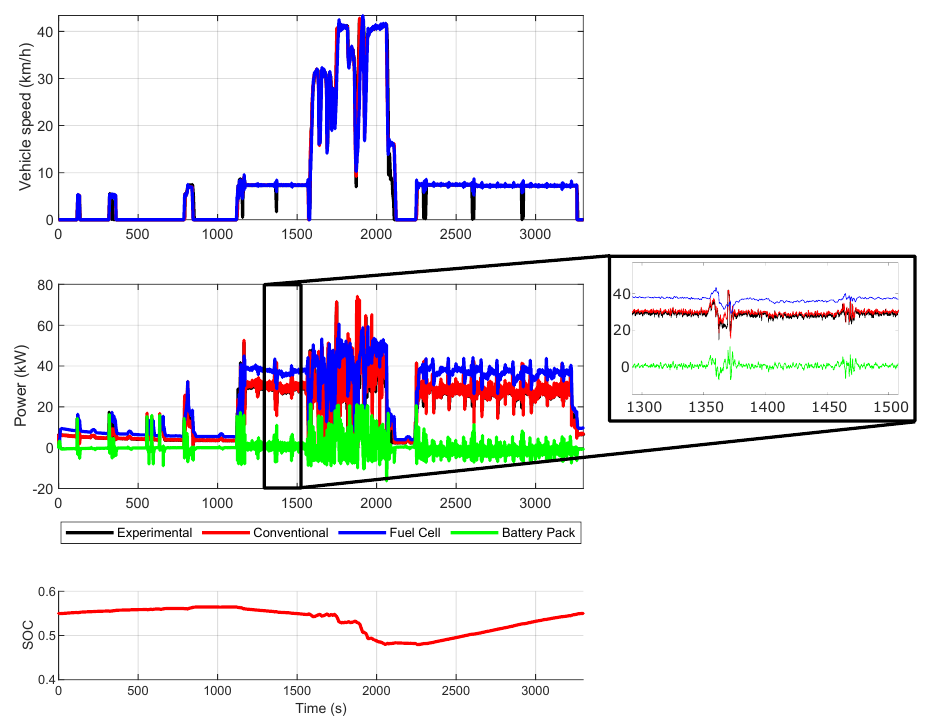
Figure 15. Simulation results for the weeding work cycle.